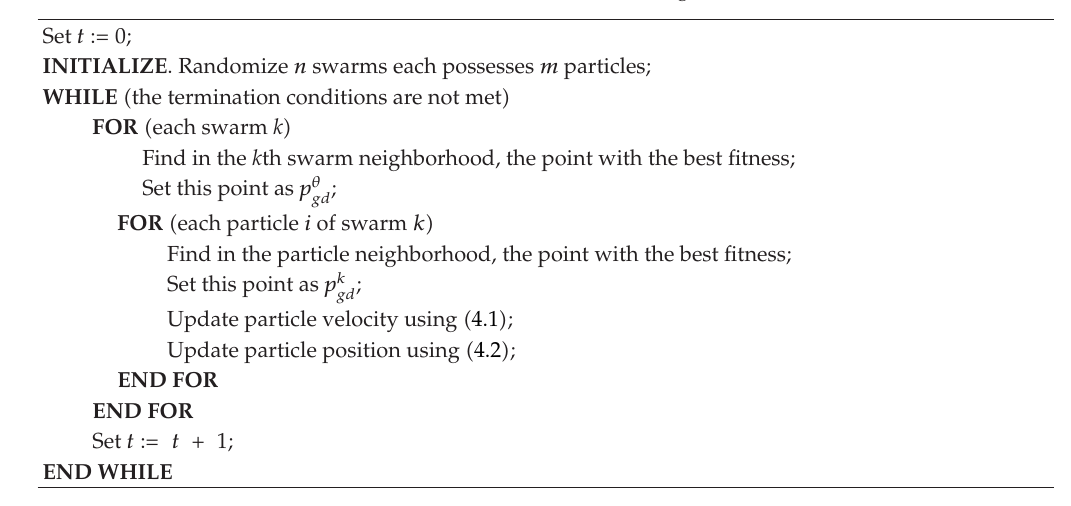
Table 1: Pseudocode for the PS 2 O algorithm.